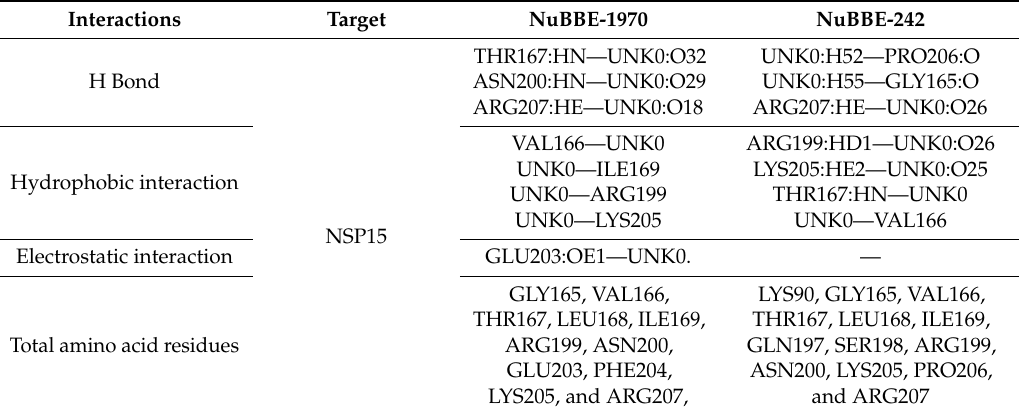
Table 1. Interacting amino acid residues of NSP15 with NuBBE-1970 and NuBBE-242.